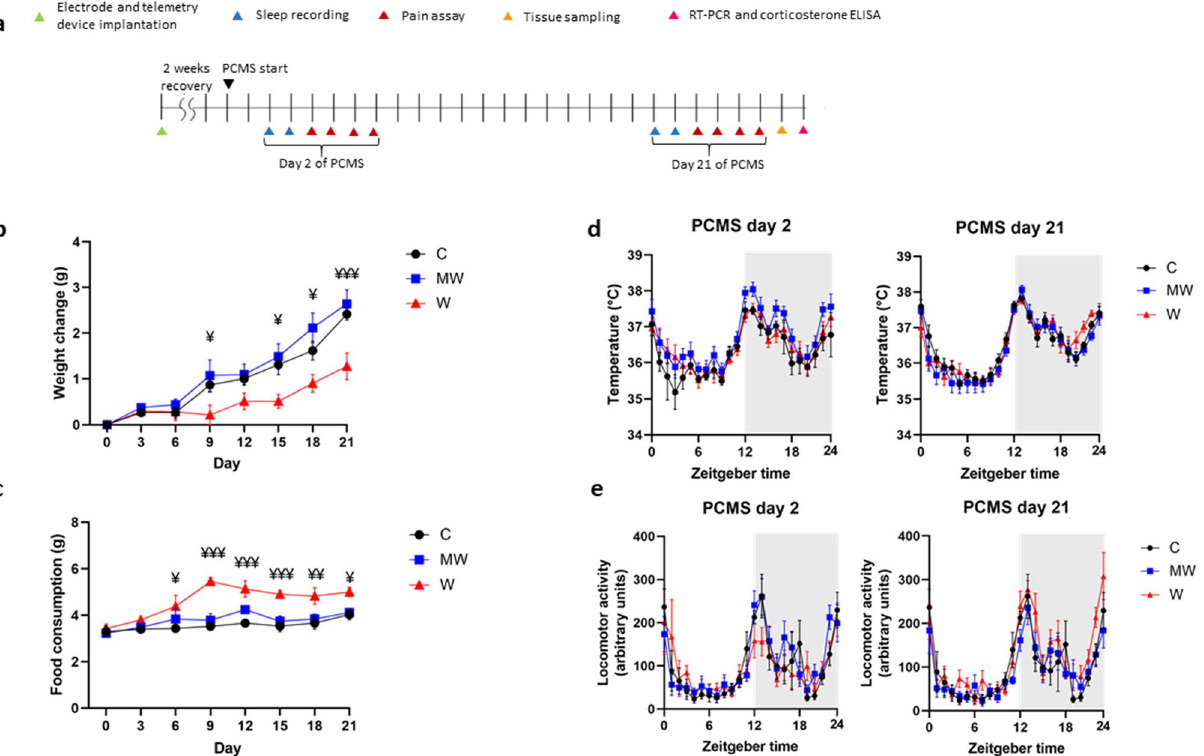
Figure 1. Weight changes, food consumption, core body temperature, and locomotor activity. The experiment timeline showing sleep and pain tests during predictable chronic mild stress (PCMS) ( a ). Significant weight decrease was seen in the water (W) group on days 9, 15, 18, and 21 of the PCMS timeline compared to the control (C) group ( b ). Food consumption increased for the W group on days 6, 9, 12, 15, 18, and 21 ( c ). No changes in terms of core body temperature were observed ( d ). There were no significant changes in locomotor activity as well ( e ). N = 6–7 per group; ¥ p < 0.05, ¥¥ p < 0.01, ¥¥¥ p < 0.001 (W vs C); two-way repeated-measures ANOVA followed by Dunnett’s multiple comparison test. Data are presented as means ±